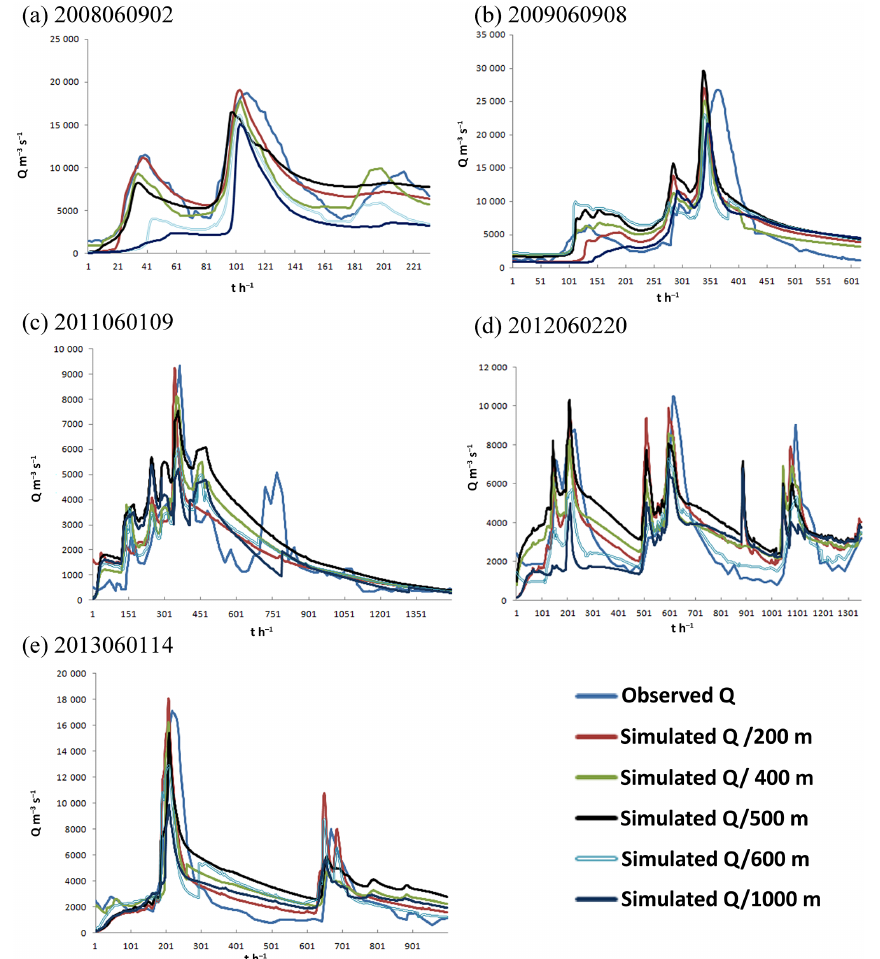
Figure 7. Simulated results with different model